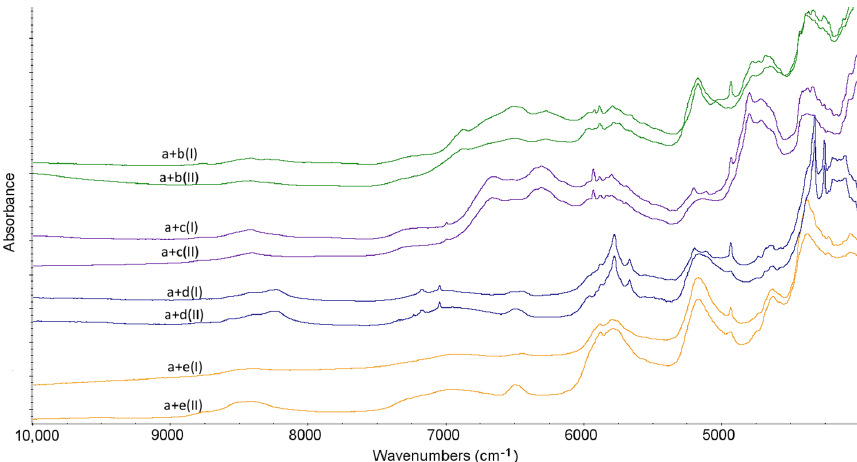
Figure 9. NIR spectra for binary mixtures of linagliptin (a) with lactose (b), mannitol (c), magnesium stearate (d) and polyvinylpyrrolidone (e) in the non-stressed (I) and stressed (II) samples.